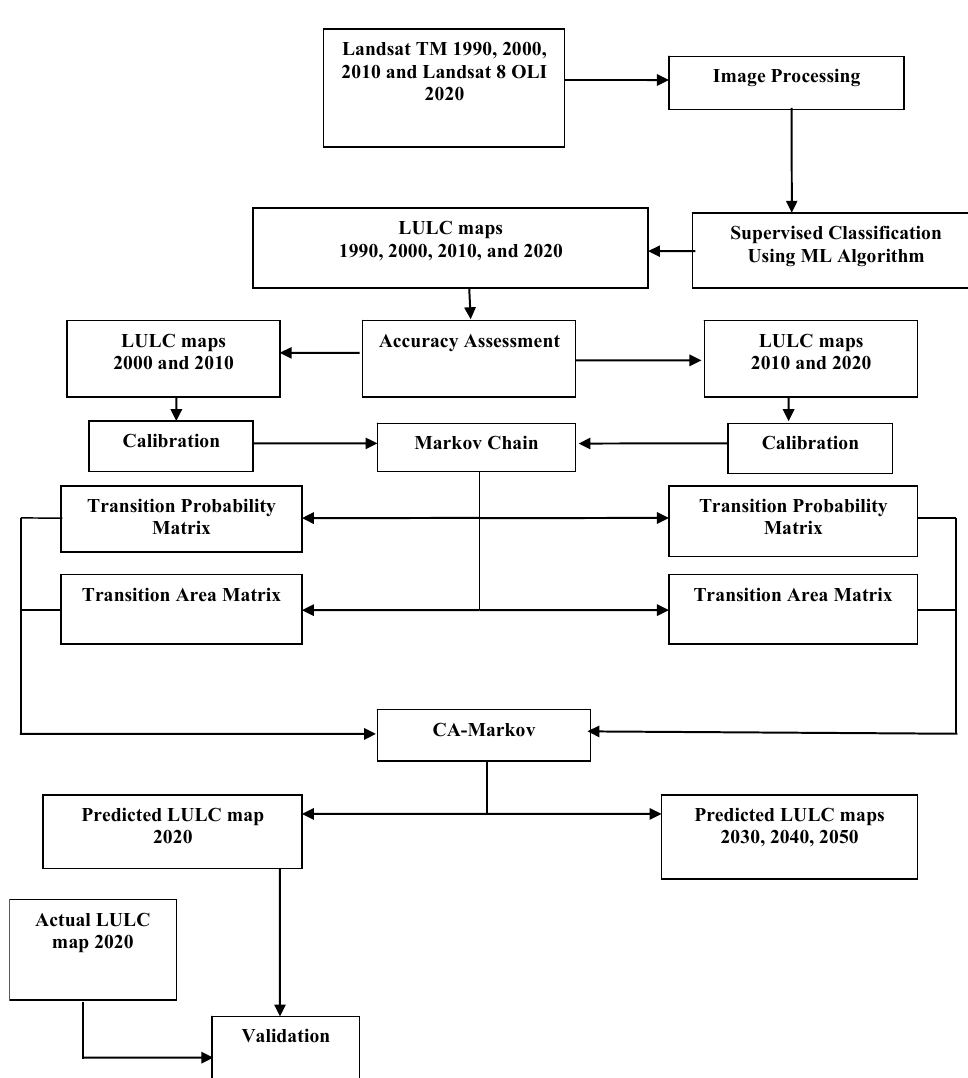
Figure 2. Flowchart of the methodology applied in the present study.